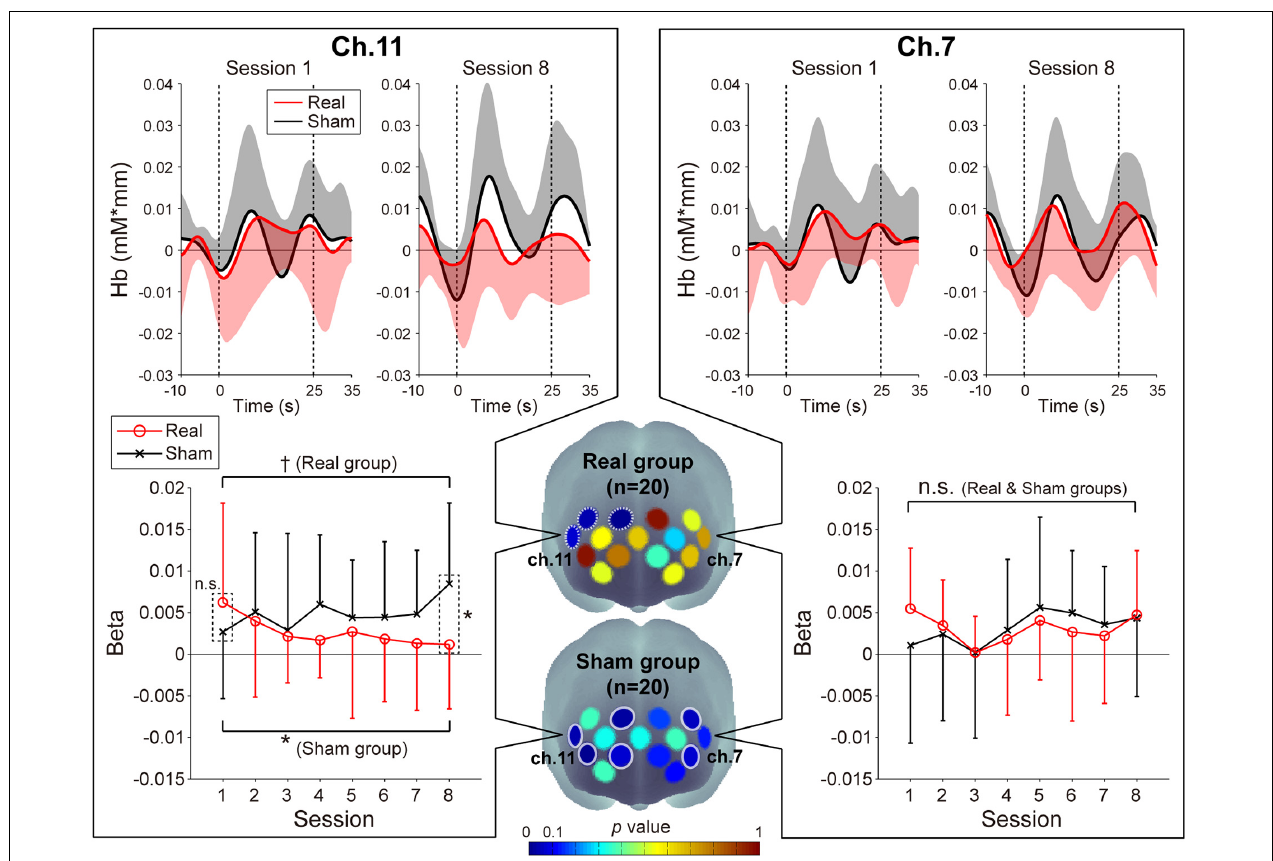
FIGURE 2 | Neuromodulations of the prefrontal cortex activity during the neurofeedback training task. Upper panels: The temporal profiles of the oxy-Hb signals in ch.11 (left panels) and ch.7 (right panels). The red and black lines represent the time courses of the oxy-Hb signals in the Real and Sham groups, respectively. The lighter colored regions around the time course lines denote the standard deviation. The upper or lower directional standard deviation regions are shown for the profiles of the Real and Sham groups, respectively. In ch.11, compared to the first session, the oxy-Hb signal in the final session tended to decrease in the Real group and increase in the Sham group. Lower panels: Beta value transitions in ch.11 (left panels) and ch.7 (right panels). In the first session of ch.11, although there was no significant difference in the beta value between the Real and Sham groups, the Real group showed significantly lower activity than the Sham group at the final session. In contrast, in ch.7, no significant beta value change was observed in both groups. Middle lower 3D brain illustrations: Spatial configurations of the p -values from the simple-simple main effect test comparing the beta value in the first session and that in the last session. In the Real group, activities focally decreased in the right hemisphere, including the feedback channel (white dotted circles), while in the Sham group, large activity increases were observed in the bilateral broad region (white solid circles). Error bars denote the standard deviation. † p < 0.1, * p <